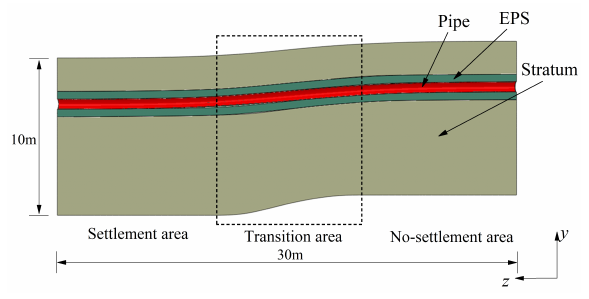
Fig. 1. Schematic diagram of stratum